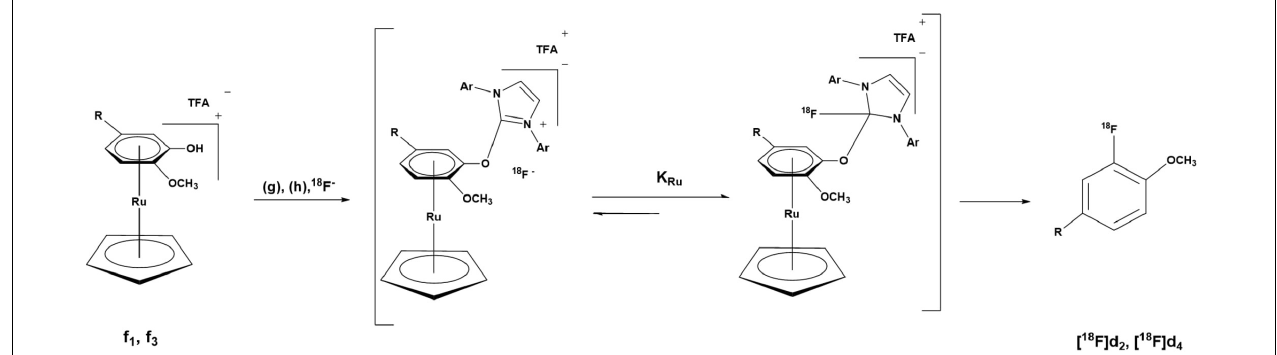
FIGURE 7 | Deoxyradiofluorination of the DABTA-ruthenium complexes at 130 ◦ C for 30-35 min, with g = 2-Chloro-1,3-bis(2,6-diisopropylphenyl)imidazolium chloride, h = ethanol: pivalonitrile: veratrole (1:4:4), TFA = trifluoroacetic acid (counteranion obtained as a result of semipreparative purification with TFA-acidified solvents). For “R,” see Figure 3